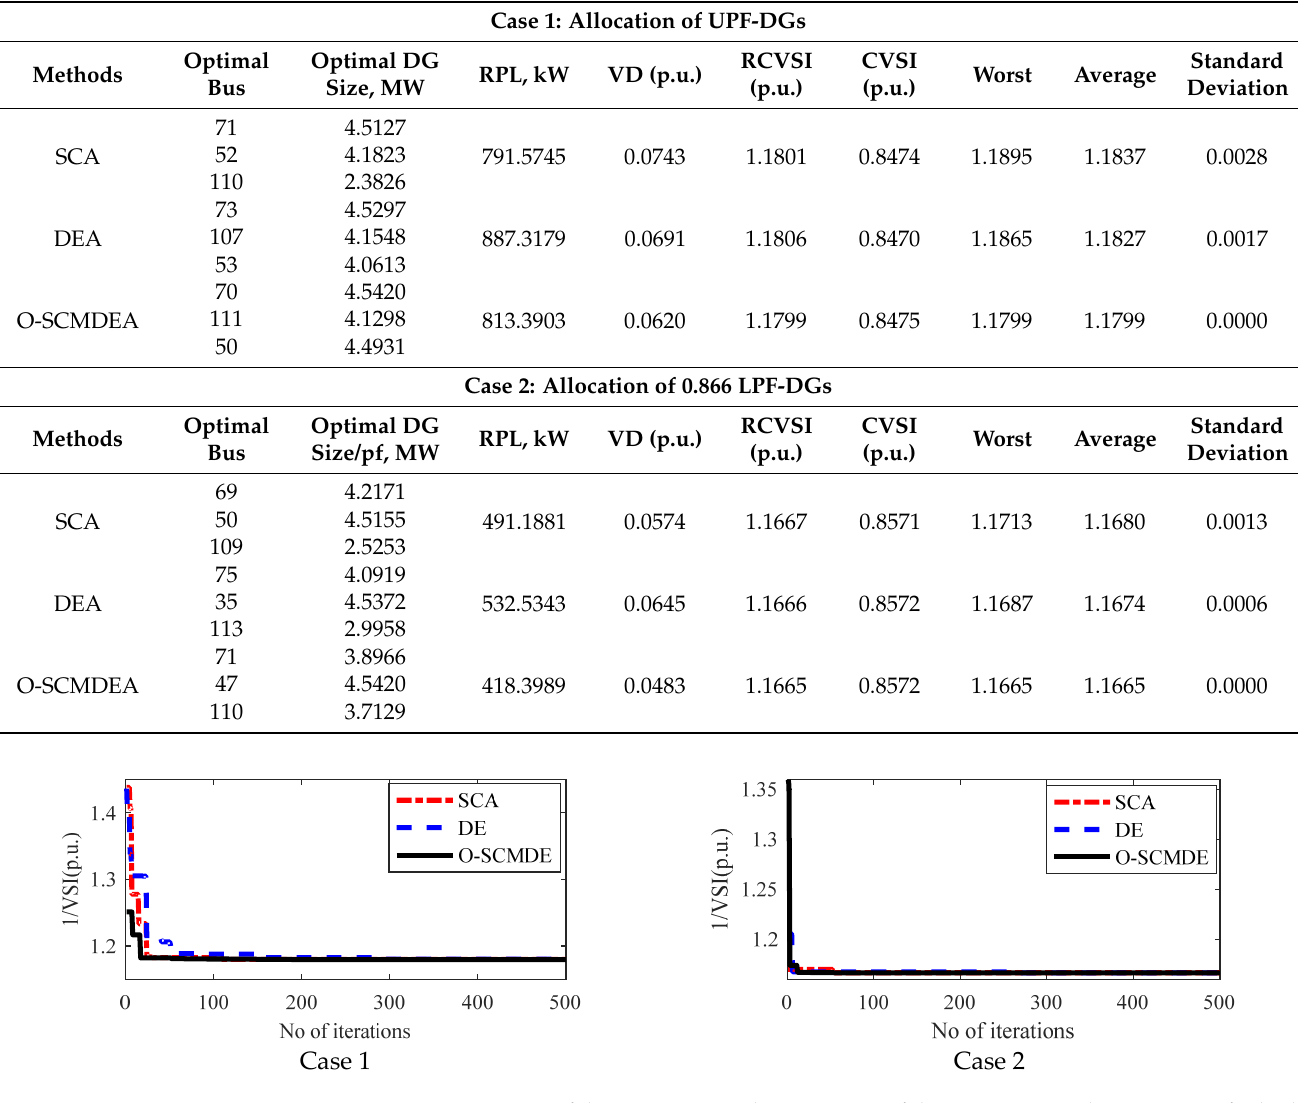
Figure 10. Comparison of the convergence characteristics of the SCA, DEA and O-SCMDEA for both cases of scenario III of the 118 bus system.